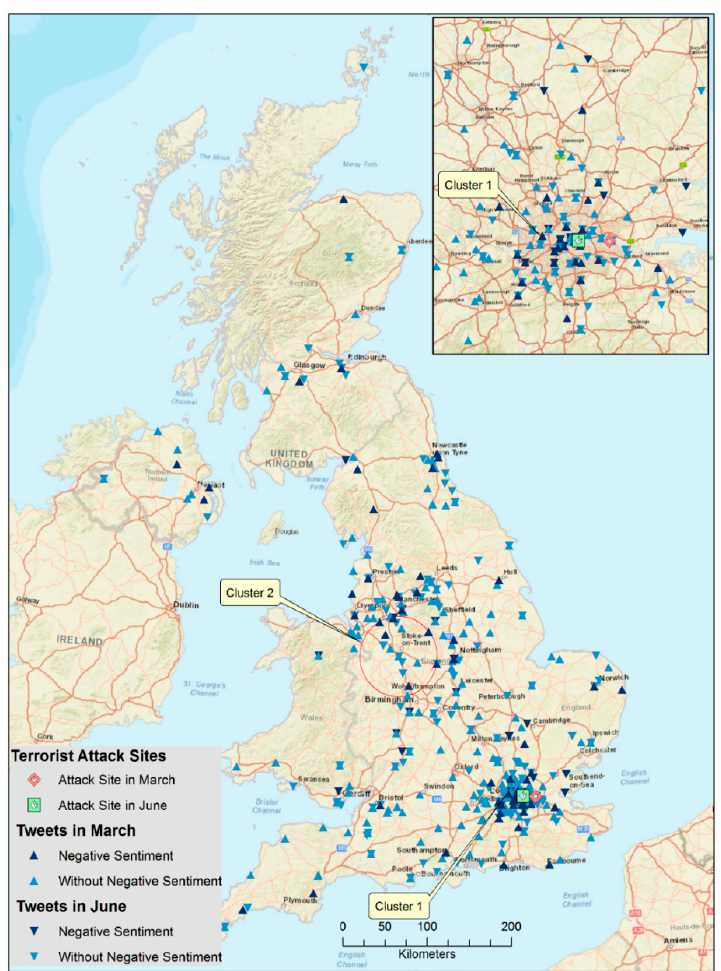
Figure 2. Clustering of Geotagged Tweets in the United Kingdom.